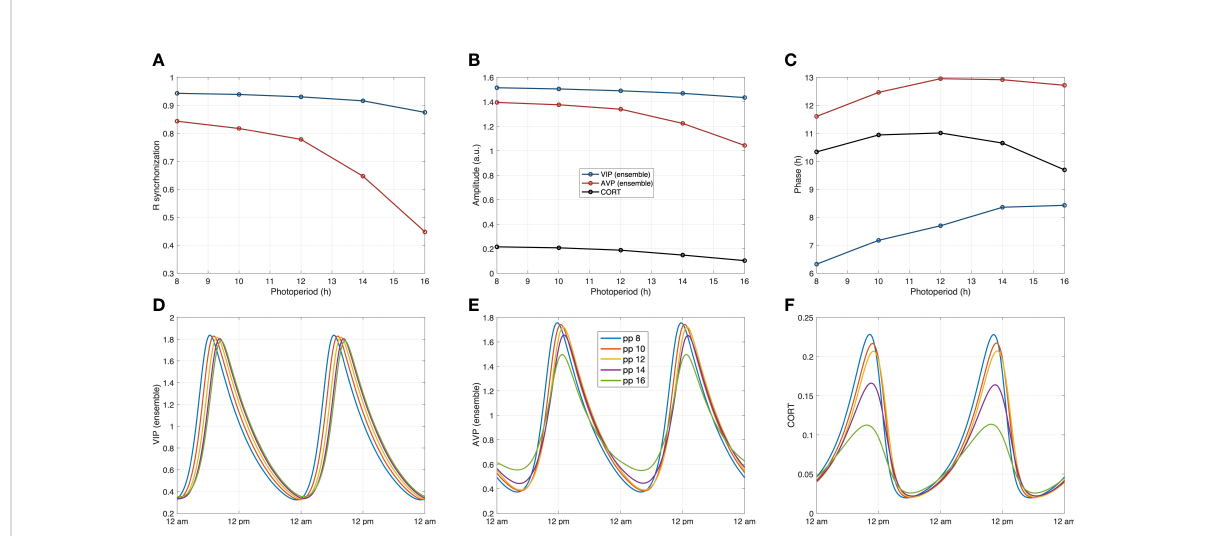
FIGURE 9 System ’ s dynamics under photoperiod changes. (A) The calculated synchronization level Rsyn in both the core and the shell decrease as the photoperiod increases. (B) The reduced synchronization results in lower ensemble average amplitudes of the core and the shell under longer photoperiods, which further leads to the decrease in corticosterone amplitude. (C) The core exhibits a phase delay as the photoperiod increases, while the phase changes of the shell and the HPA axis are nonmonotonic. (D – F) : The circadian dynamics of the representative components of the core the shell, and the HPA axis under different photoperiods. The phase and amplitude relationships are consistent with the observations in Figures (A – C)